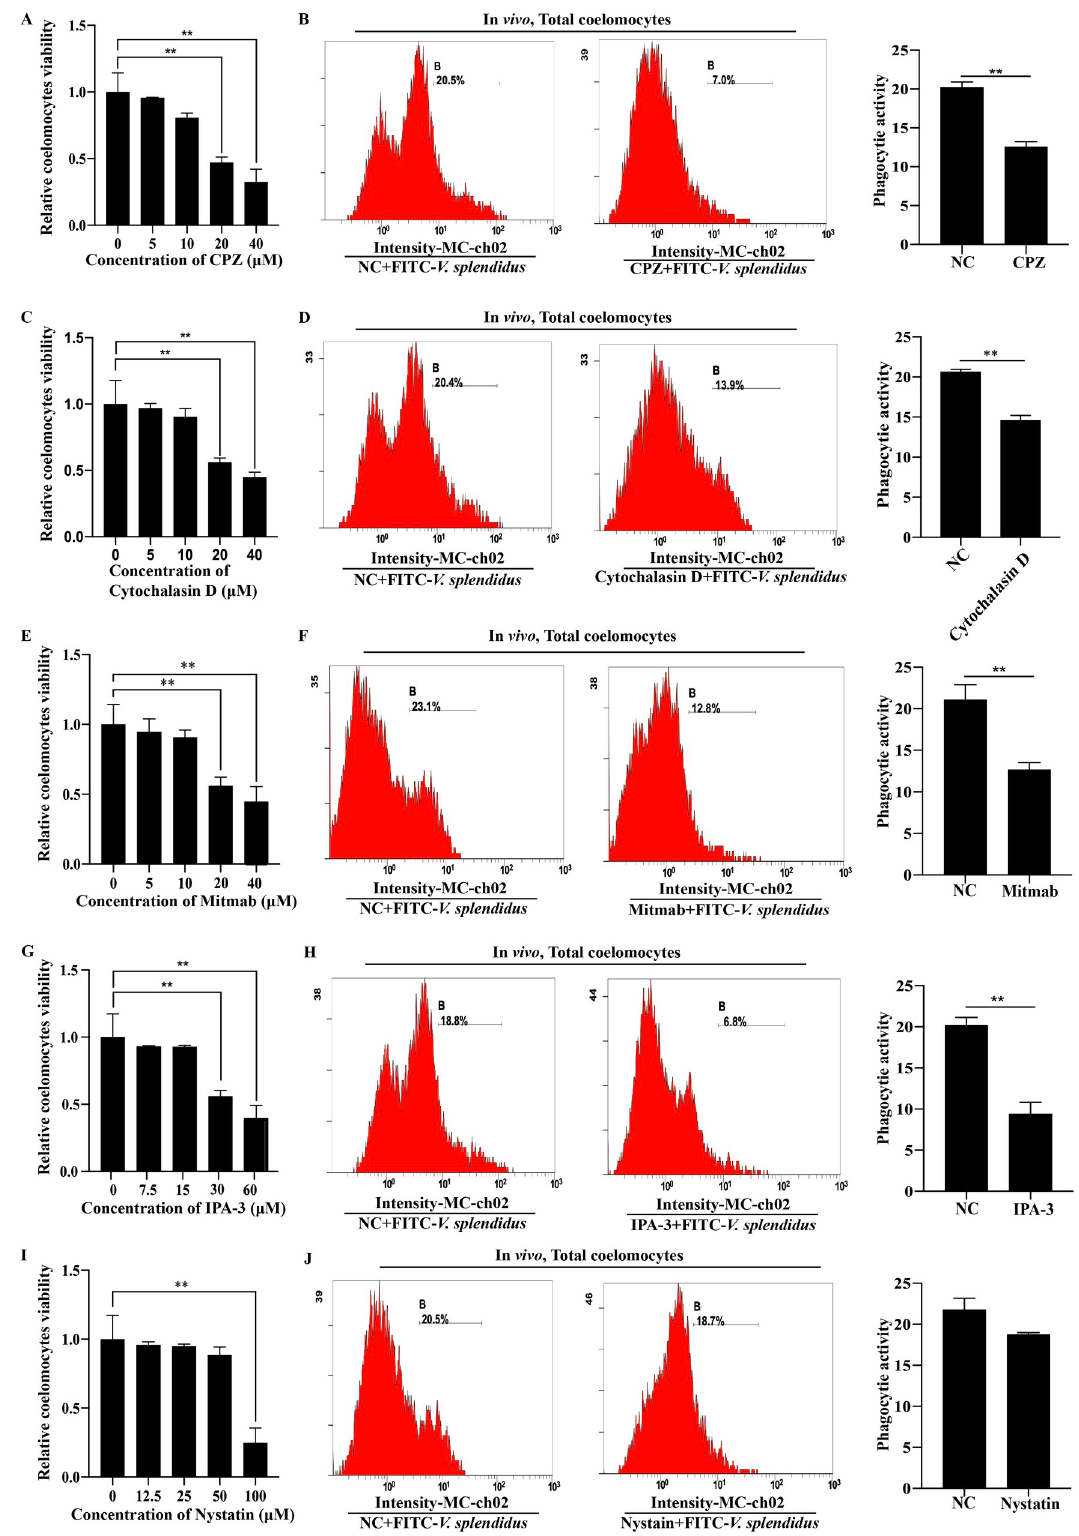
Fig 5. V . splendidus enters coelomocytes of sea cucumber through multiple endocytic pathways. (A) The effect of chlorpromazine (CPZ) on the cell viability of sea cucumbers. Sea cucumber coelomocytes were treated with increasing concentrations of CPZ for 3